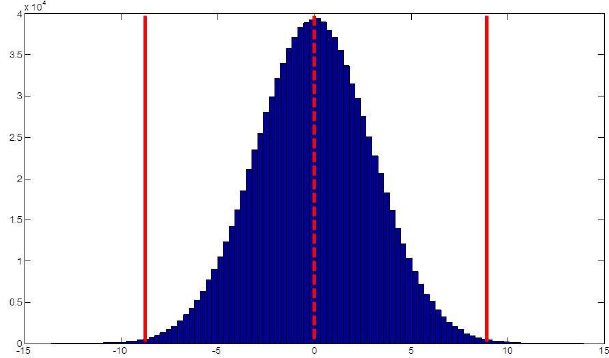
Fig. 2. Histogram of simulated data following a Gaussian distribu- tion with normalized mean 0 (dotted red line) and standard deviation of 3. The range of values that lie between 3 standard deviations of the mean (solid red lines) represent 99.7% of all the